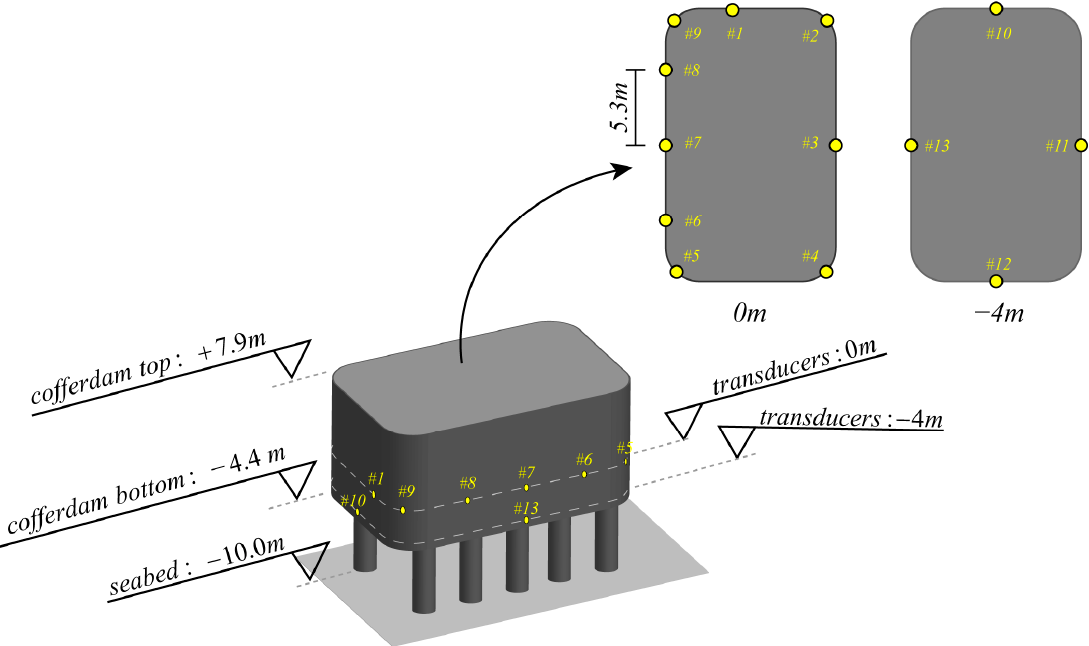
Figure 3. Setup of the transducers.